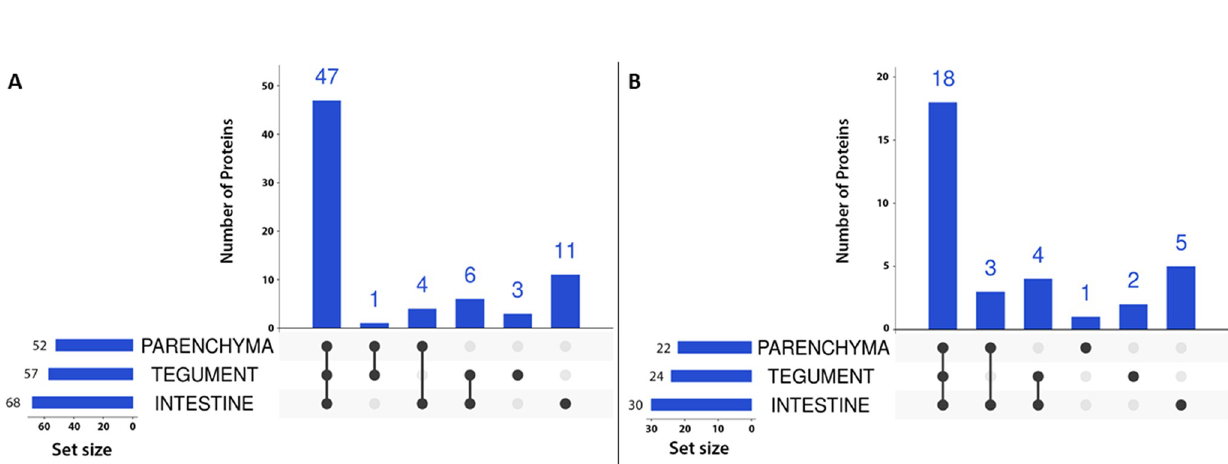
Fig 4. UpSet plots showing the number of peptidases (A) and inhibitors (B) in each tissue. Only proteins identified by � 2 peptides in at least one replicate are considered. Proteins common to several tissues are marked by connected black dots. Black dots without connections refer to proteins unique to that tissue.